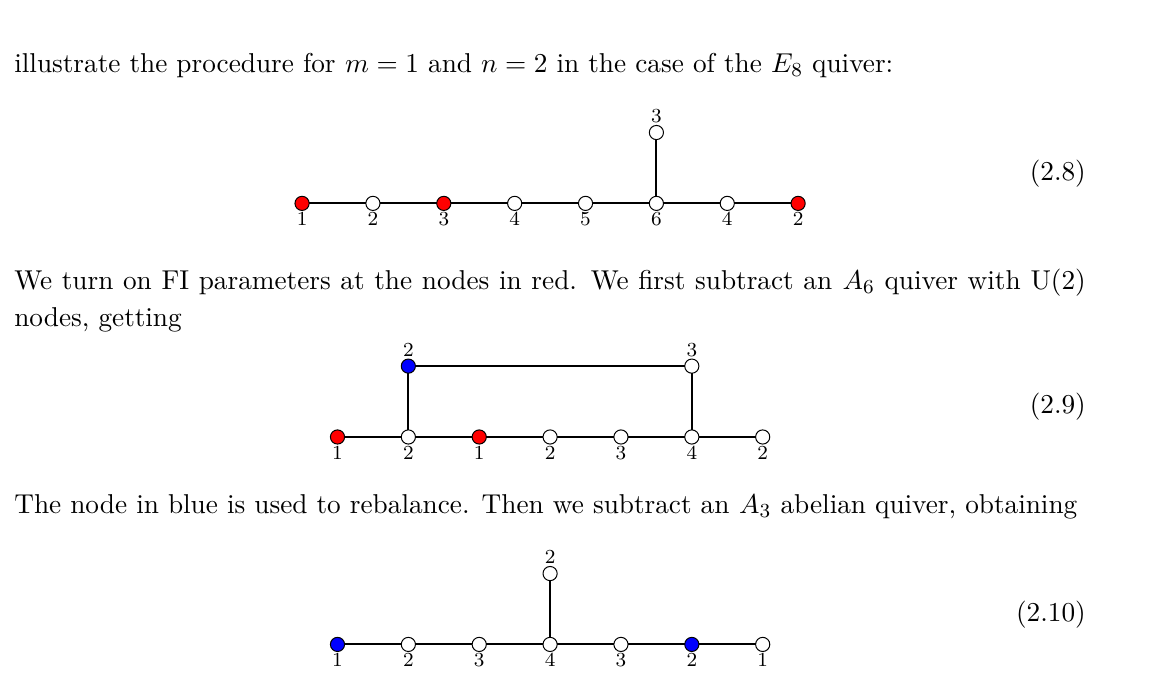
Figure 1. One FI deformation leading from the SO(12) × U(1) SCFT to its low-energy gauge description, namely SU(3) SQCD with 6